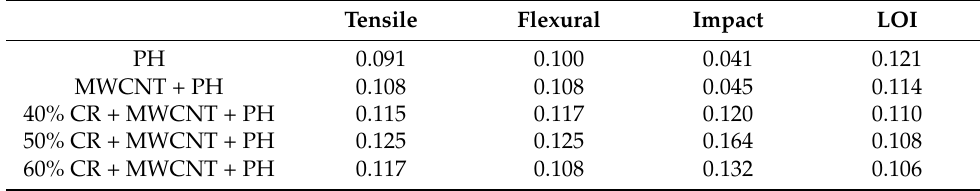
Table 8. The weighted normalized matrix.